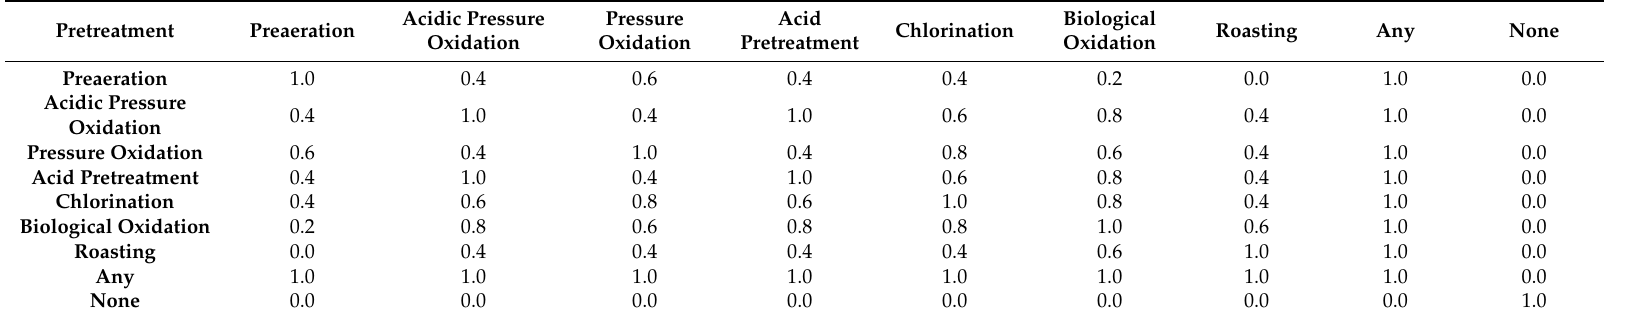
Table 2. Similarity table for the attribute Pretreatment